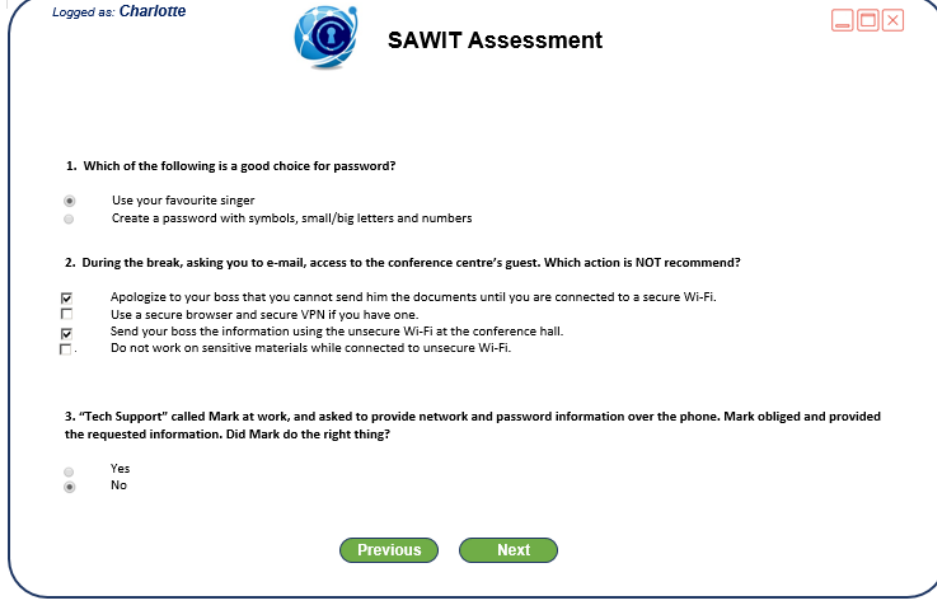
Figure 4. SAWIT assessment dialog.